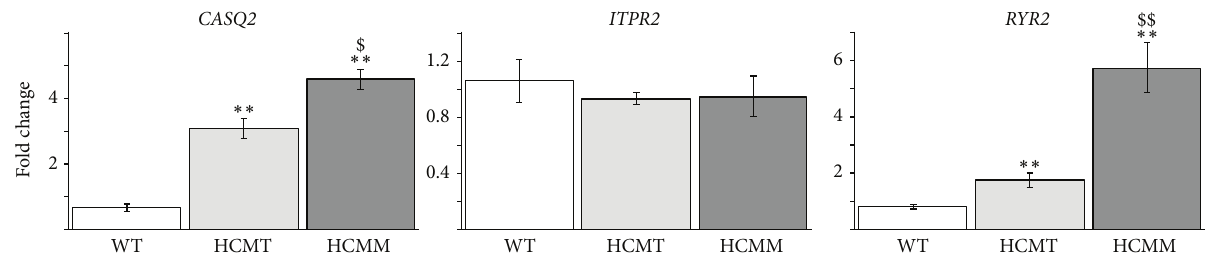
Figure 4: Gene expression profiles in control hiPSC-derived CMs (WT) and in hiPSC-derived CMs carrying TPM1-Asp175Asn (HCMT) or MYBPC3-Gln1061X (HCMM) mutations. ( ∗ represents HCMT or HCMM versus WT, and $ represents HCMT versus HCMM. ∗∗ or $$ 𝑝 < 0.005 , ∗ or $ 𝑝 < 0.05 𝑛 = 16 , except for NPPA 𝑛 = 8